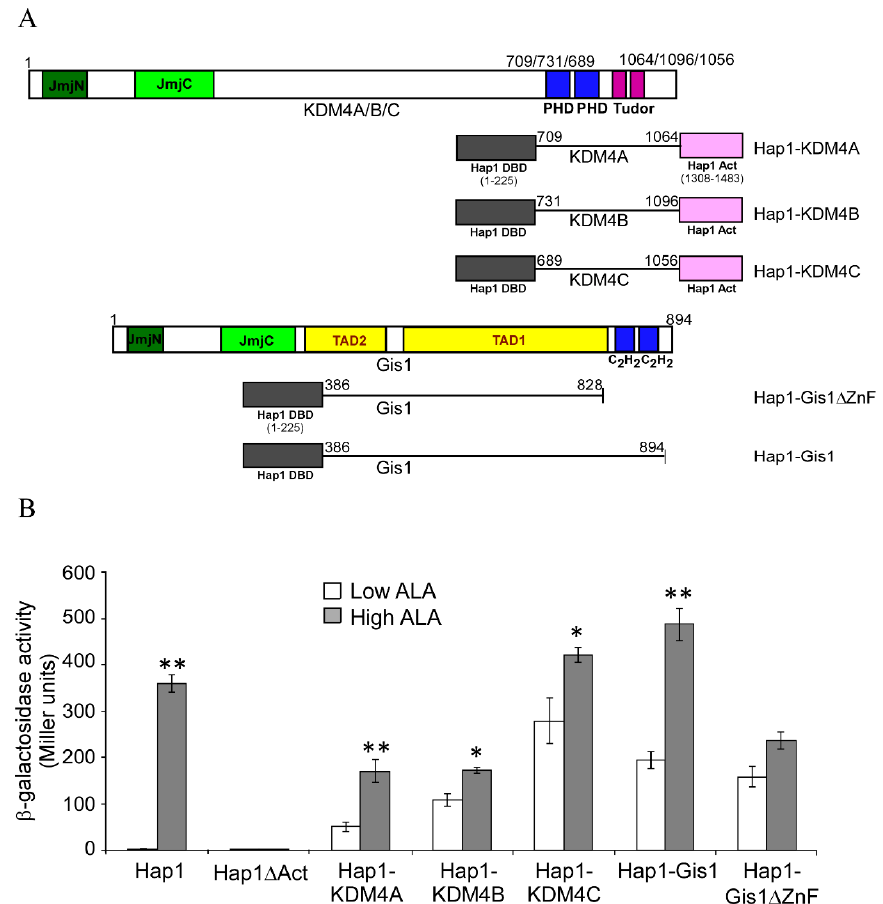
Figure 5. The C-terminal domains of KDM4 proteins can confer heme regulation of transcriptional activity via an unrelated transcription factor. ( A ) The domain maps of the hybrid proteins are shown.